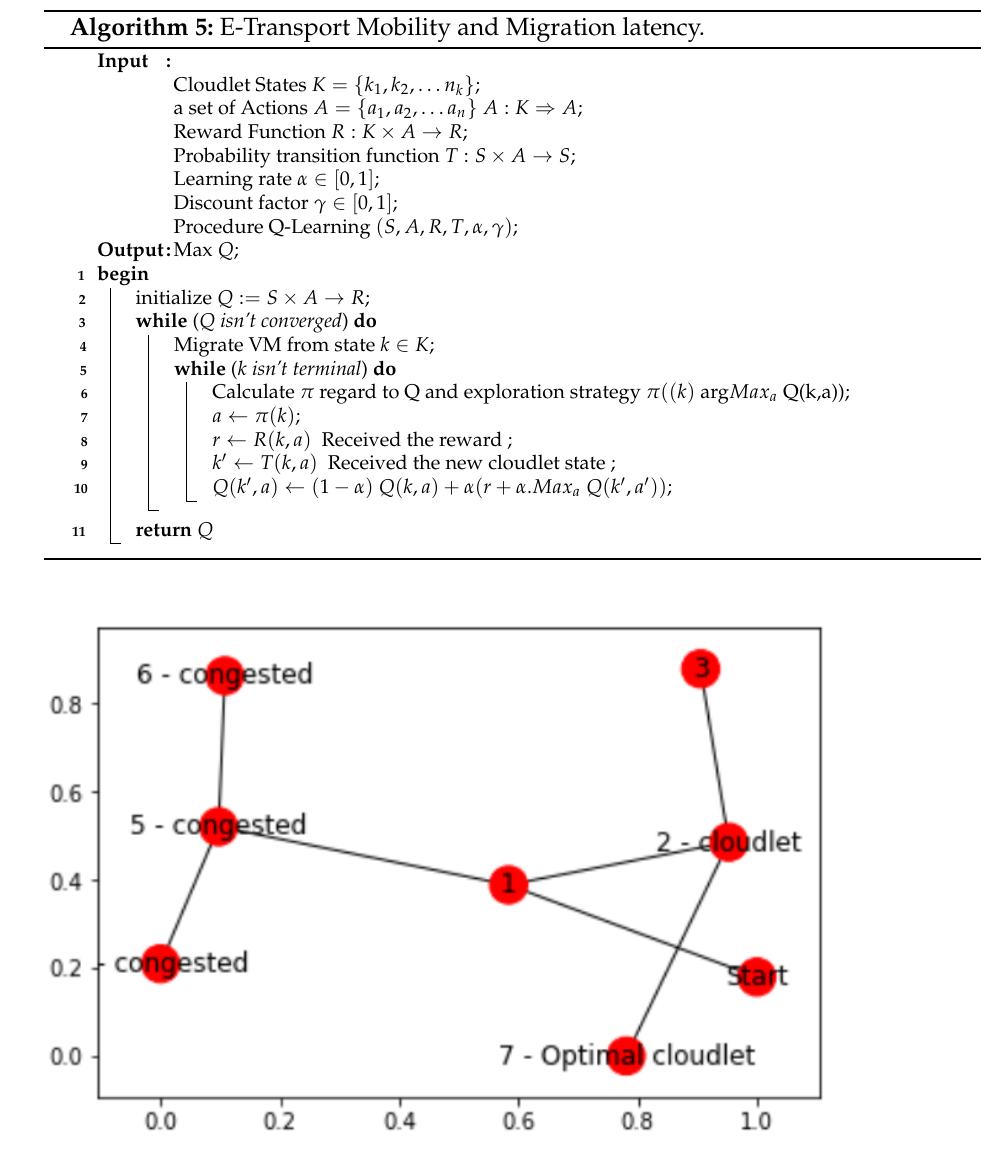
Figure 5. Training Model of Proposed